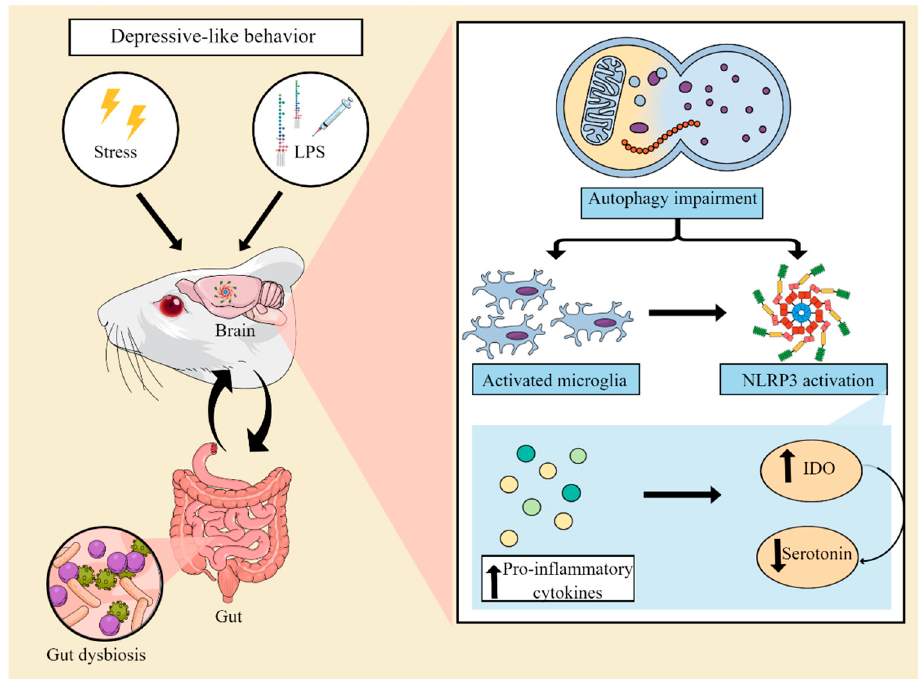
Figure 2. Involvement of the NLRP3 inflammasome in preclinical models of depression. Animal models of depression induced by stress or an inflammatory challenge with lipopolysaccharide (LPS) have been used to elucidate the mechanisms involved in the pathophysiology of MDD. These mod- els are able to induce a neuroinflammatory process, associated with an impairment of autophagic pathways and microglial activation. This process leads to the assembly and activation of the NLRP3 complex. As a consequence, there is an increase in the levels of proinflammatory cytokines, which in turn result in increased indoleamine 2,3 dioxygenase (IDO) activity, decreased tryptophan bioa- vailability, and a consequent reduction in serotonin synthesis. Furthermore, NLRP3 activation has also been suggested to be associated with gut dysbiosis, compromising the production of serotonin and neuroprotective compounds by the gut microbiota. Abbreviations: NLRP3: Nod-like receptor pyrin containing protein 3. 3.2. Clinical Evidence Alcocer-Gómez et al. (2014) has reported a correlation between levels of IL-1 β and IL-18 and Beck Depression Inventory (BDI) scores. Specifically, MDD patients showed enhanced expression of NLRP3 and caspase-1 in blood cells, resulting in increased serum levels of IL-1 β and IL-18 [60]. Similarly, a recent study showed that NLRP3 and caspase- 1 mRNA levels were significantly elevated in MDD patients when compared with healthy controls [61]. A study conducted with postmortem brains of individuals afflicted with MDD that died by suicide assessed the involvement of other NLRPs inflammasomes in depression. In this study, protein and mRNA expression levels of ASC, NLRP3, NLRP1, NLRP6, and caspase-3 were shown to be significantly increased in the prefrontal cortex of MDD indi- viduals when compared to healthy controls. In addition, an increase in both mRNA and protein levels of IL-1 β , TNF- α and IL-6 was also observed [62]. As such, future studies are warranted to further elucidate the involvement of other inflammasomes in MDD. In other studies, NLRP3 inflammasome-induced increases in the levels of several in- flammatory such as IL-1 β , IL-6, and TNF- α have also been observed in individuals with MDD [63,64]. However, there are some inconsistencies between studies regarding the ob- served increases of cytokines [65,66]. For example, while one meta-analysis study re- ported significantly higher concentrations of TNF- α and IL-6 in MDD afflicted individuals when compared to healthy controls [65], another meta-analysis study observed no con- sistent association between TNF- α and IL-1 β levels and MDD [66]. Therefore, more